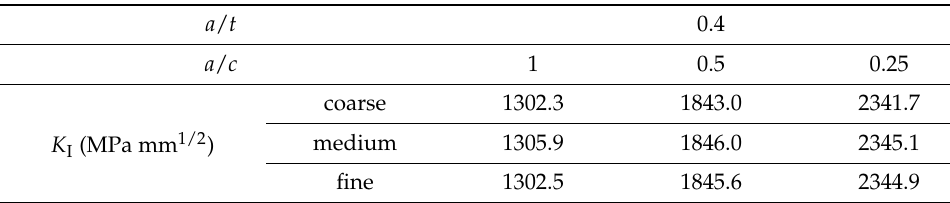
Table 3. SIF results for different